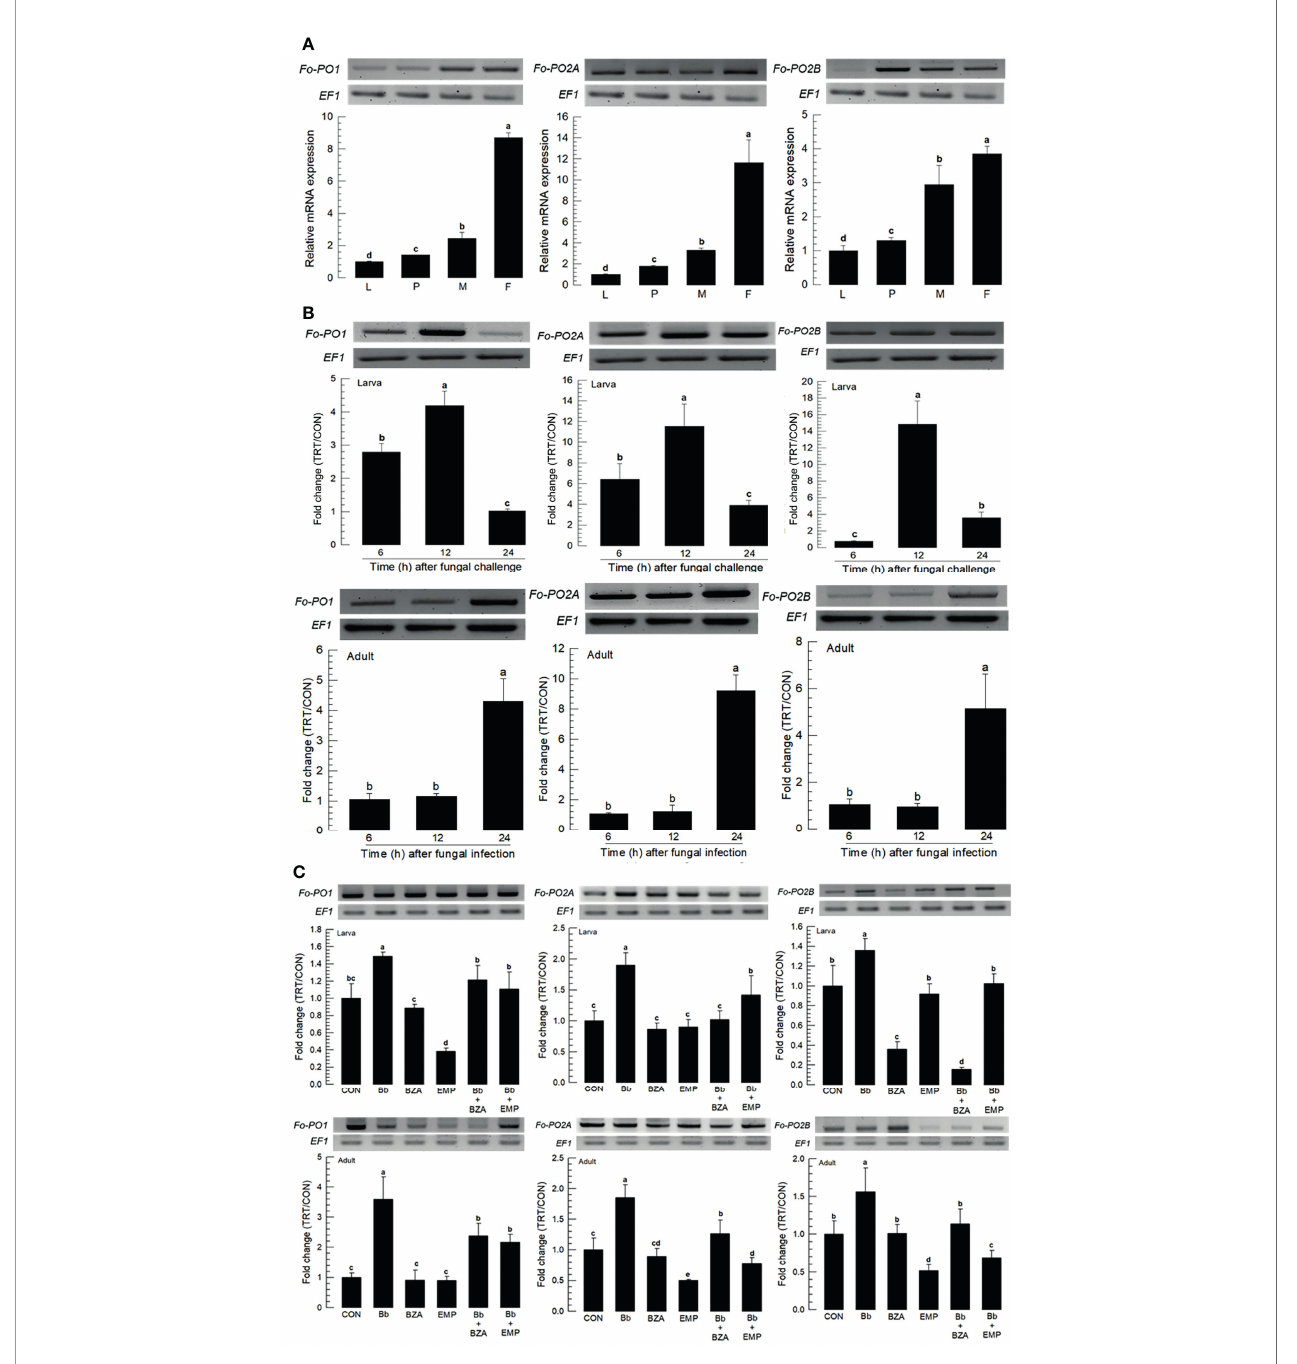
FIGURE 8 | Inducible expression of three prophenoloxidases (PO) in F. occidentalis ( Fo-PO ) named Fo-PO1 , Fo-PO2A , and Fo-PO2B upon fungal challenge. (A) Expression levels of Fo-PO in different developmental stages of larva ( ‘ L ’ ), pupa ( ‘ P ’ ), male ( ‘ M ’ ), and female ( ‘ F ’ ) adult. RNA samples were collected from the whole body extracts of larvae (~100), pupae (~100), or adults (~100) for each treatment. (B) Inducible expression of Fo-PO in L2 larvae or adults upon a fungal challenge with Beauveria bassiana (1×10 6 conidia/mL) at different time points. RNA samples were collected from the whole body extracts of larvae (~100) or adults (~100) for each treatment. (C) Inhibitory effect of EMP or BZA on the expression of Fo-PO in larvae or adults. To check this immunosuppressive activity, B. bassiana (1×10 5 conidia/mL) along with EMP (1,000 ppm) or BZA (1,000 ppm) were used in a way mentioned previously. RNA samples were collected from the whole body extracts of larvae (~100) or adults (~100) for each treatment after 24 h of post-infection. The expression of an endogenous gene, EF1 , con fi rms the equal gel loading and the integrity of the cDNA preparation. Each measurement was replicated three times. Fold changes are calculated by ratios of expression levels of immune-challenges ( ‘ TRT ’ ) over naïve ( ‘ CON ’ ) thrips. Different letters above standard deviation bars indicate signi fi cant differences among means at Type I error = 0.05 (LSD